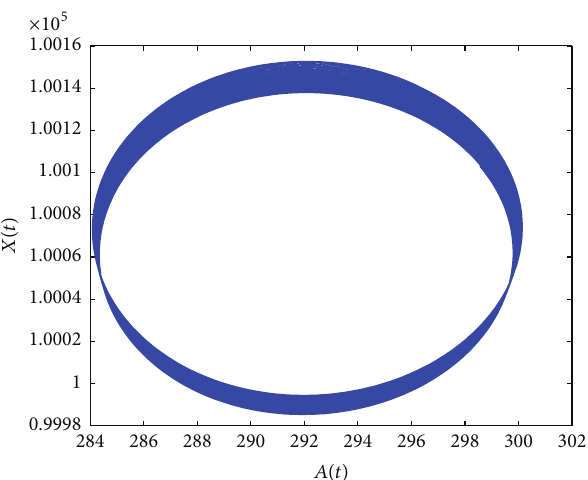
Figure 7: Periodic orbit of system (2a), (2b), (2c), and (2d) with 𝜏 = 2.50 in 𝐴(𝑡) - 𝑋(𝑡)